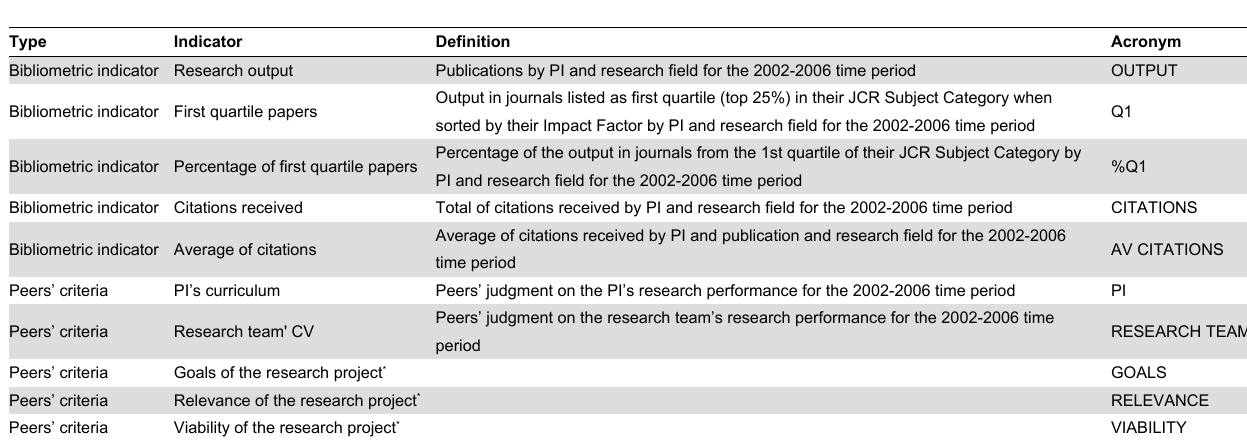
Table 2. Description of the indicators used in this study.